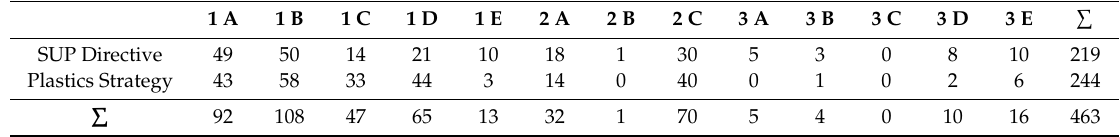
Table 1. Category frequencies per regulation.